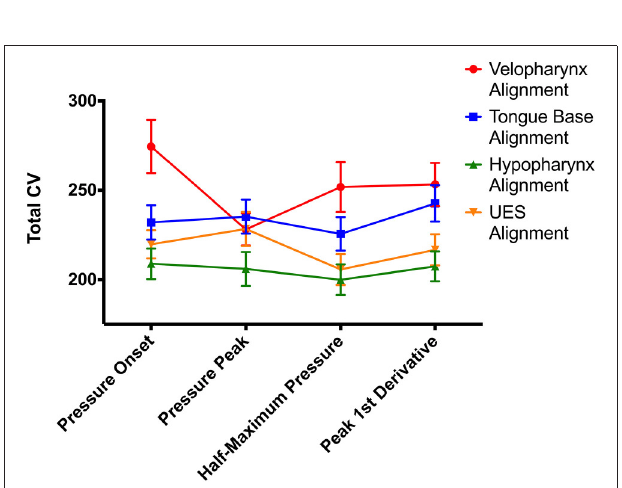
FIGURE 5 | Correlations between CV pattern , variance ratio , and intraclass correlation on all model waveform permutations. CV, coefficient of variability.